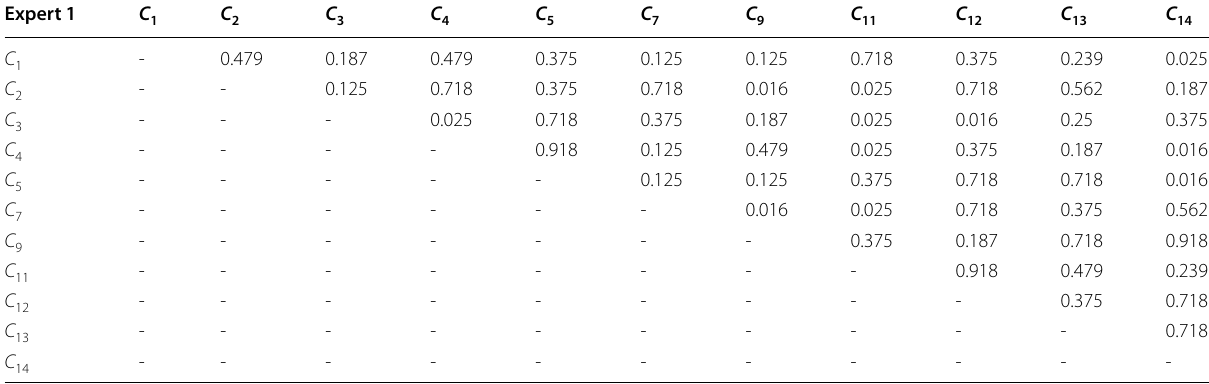
Table 4 Adjacency matrix expert opinion number 1 converted to crisp numbers Expert